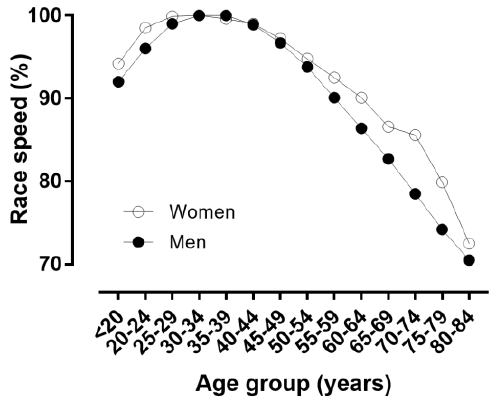
Figure 10. Running speed expressed as percentage of the speed at the age of peak performance.